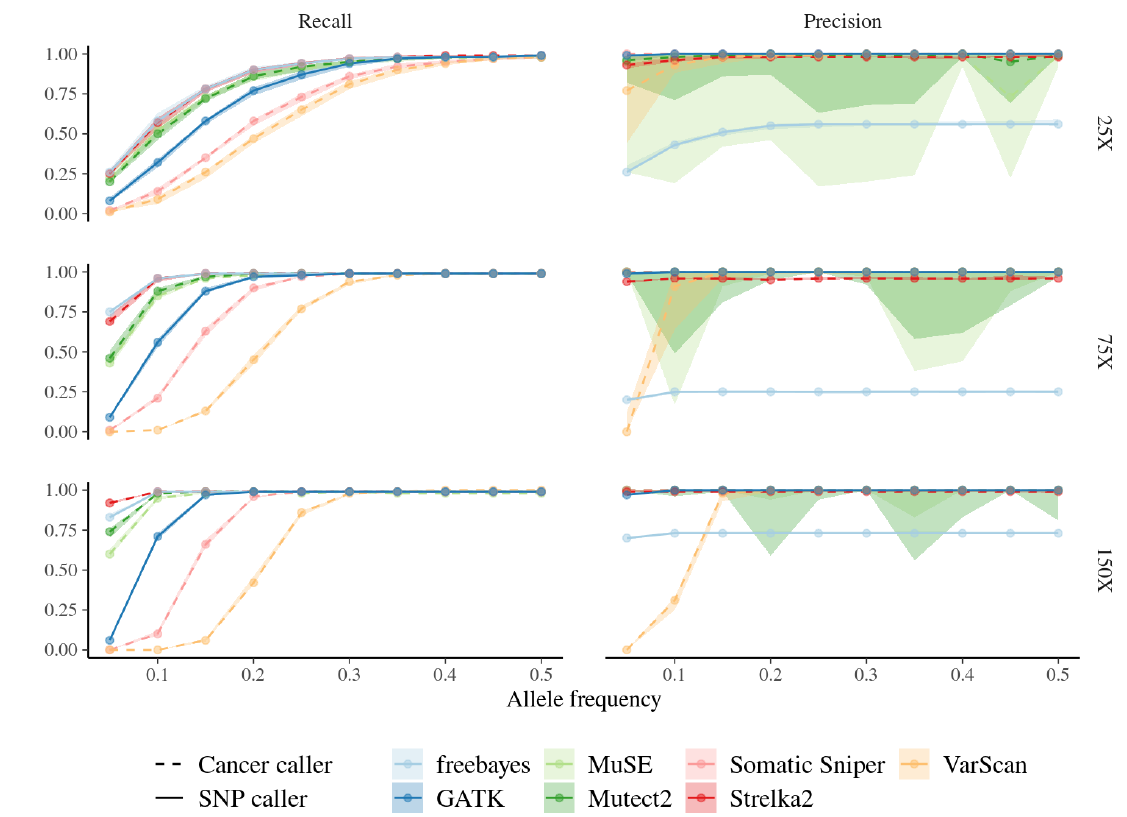
Figure 2: Variant caller performances to identify simulated mutations for varying allelic fractions and sequencing depths (see Fig. S5 for all parameter combinations). The recall is the ability to detect (recover) the simulated mutations. The precision is the proportion of simulated mutations among all variants detected (i.e. including false positives). Each point represents the averaged mutation recall or precision (10 simulations) for increasing allelic fraction and sequencing depth. The shaded area represents the variation of recall and precision rates over the 10 replicates computed for all callers, but only visible for the precision of Muse , Mutect2 , and VarScan . Linetype distinguishes SNP callers (dashed) and cancer callers